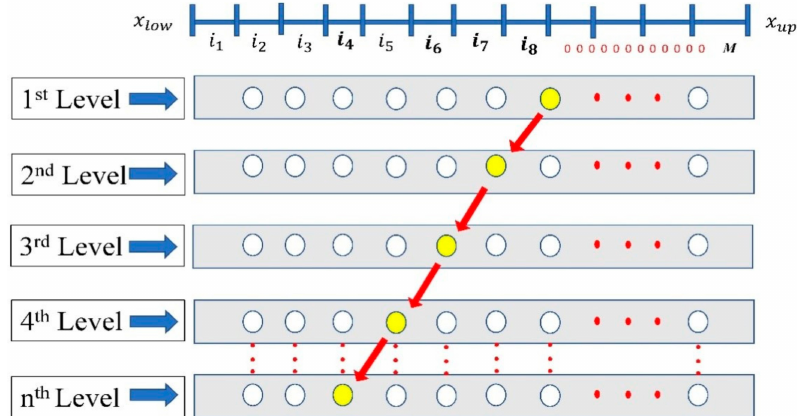
Figure 6. State space of ant colony optimization (ACO)